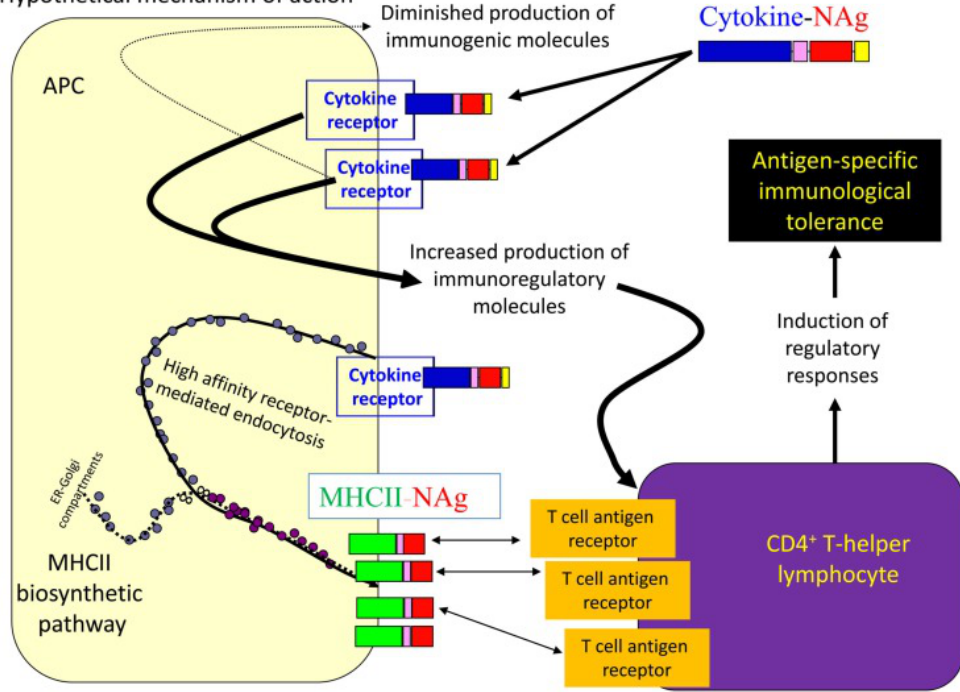
Figure 5. Mechanism of action of cytokine-NAg fusion proteins [96].